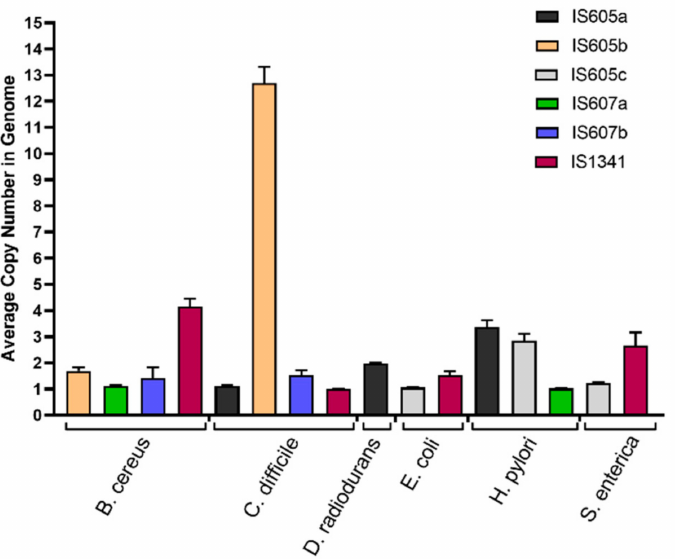
Figure 6. The average copies number of different subgroups of TCMEs in genomes of six studied bacterial species. The IS605a , IS605b , IS605c , IS607a , IS607b , and IS1341 subgroups were shown in black, orange, grey, green, blue, and red,